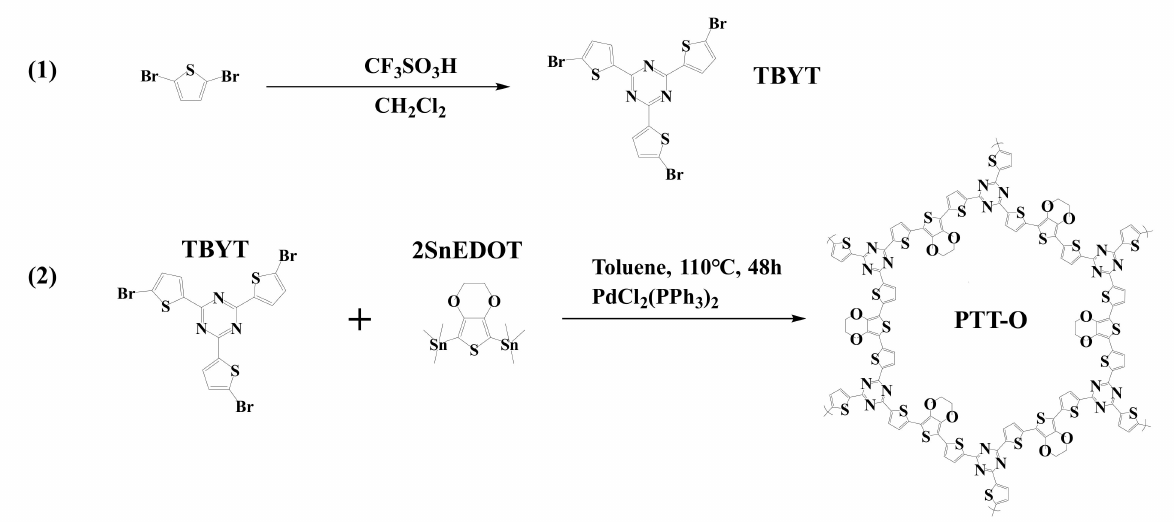
Figure 1. The synthesis route of TBYT ( 1 ) and PTT-O ( 2